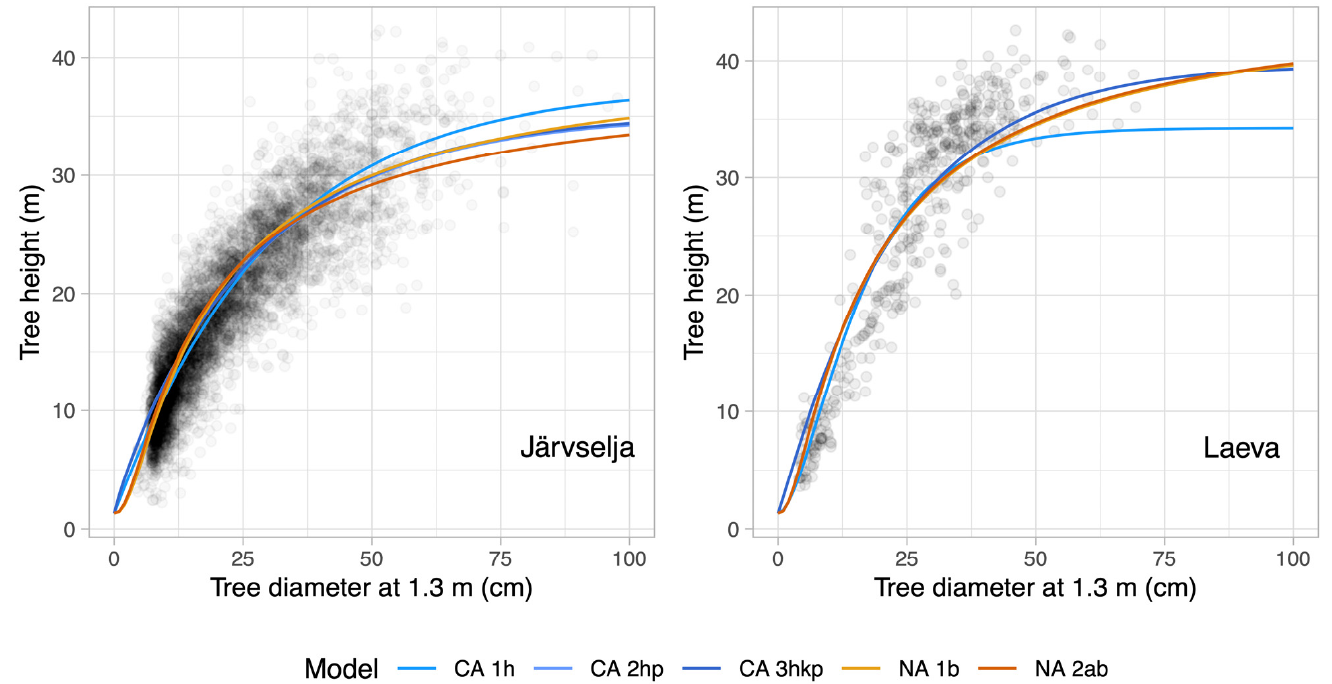
Figure 4. Comparison between H-D relation modeled with Chapman and Näslund models utilizing the nonlinear mixed- effect model approach. Blue colored relations are according to Chapman and brown-colored relations after Näslund.